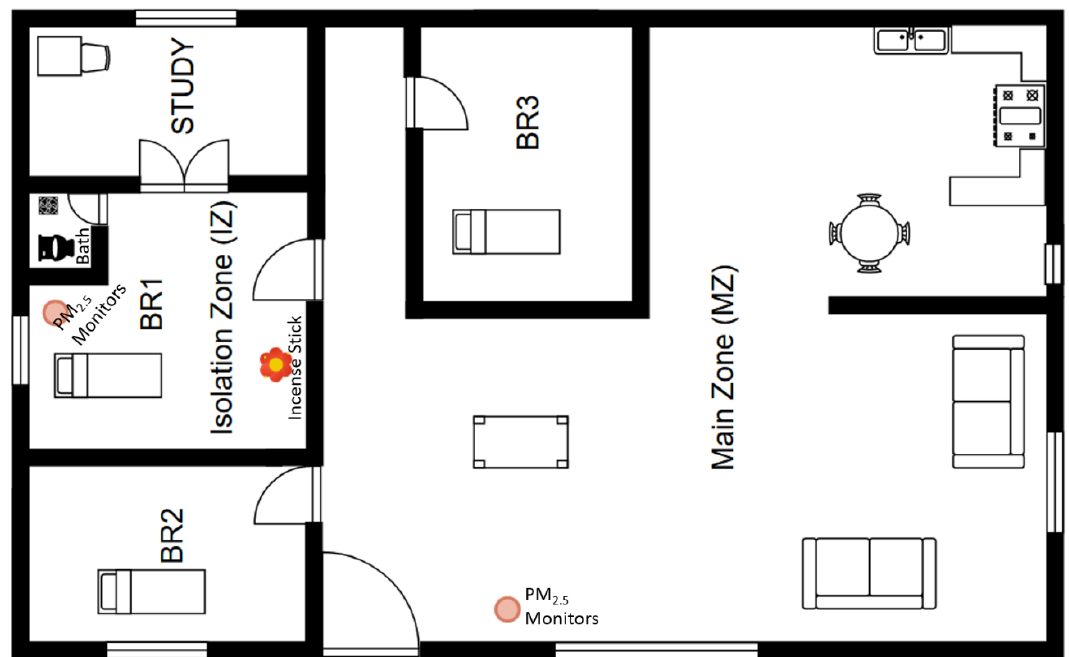
Figure A1. Generic floor plan of the house (not drawn to scale), showing various rooms, and locations of PM 2.5 monitors.